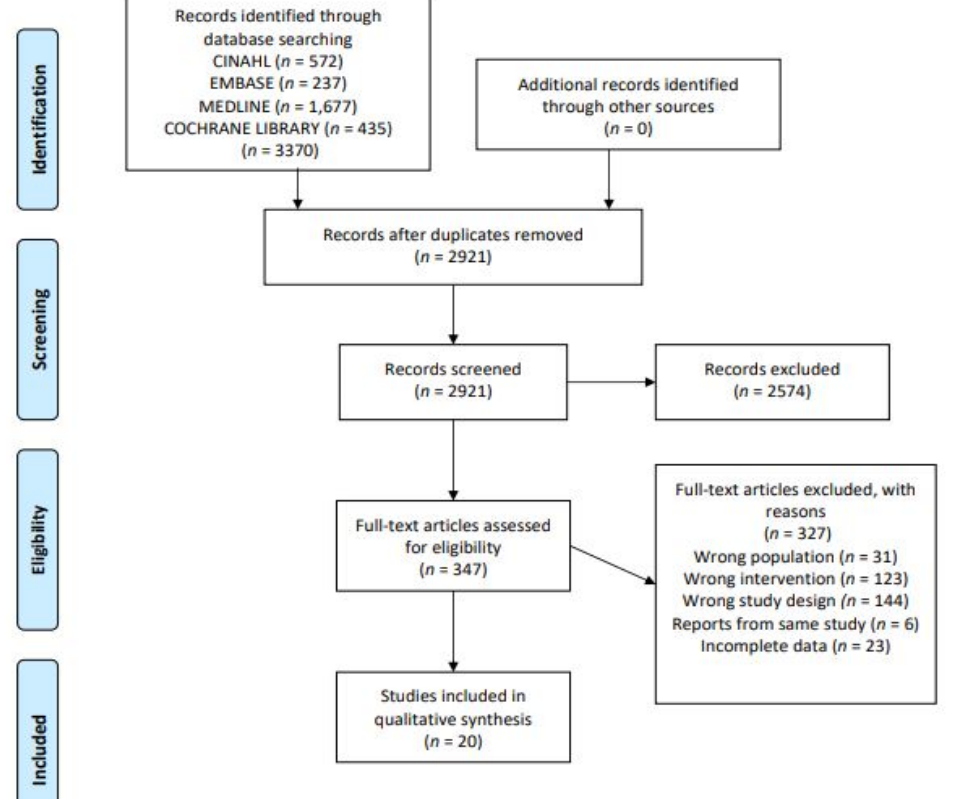
Figure 1. PRISMA flow diagram of study selection.